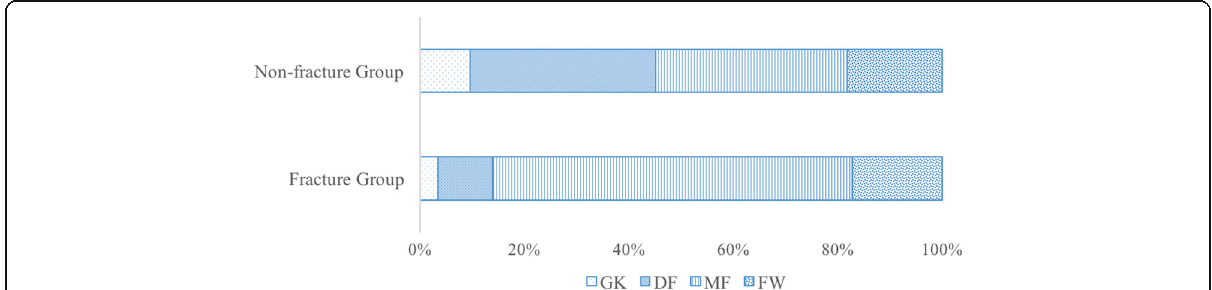
Fig. 6 Comparisons of the playing positions. GK goal keeper, DF defender, MF midfielder, FW forward. Midfield players had significantly higher rates of MT-5 fractures and defenders had significantly lower